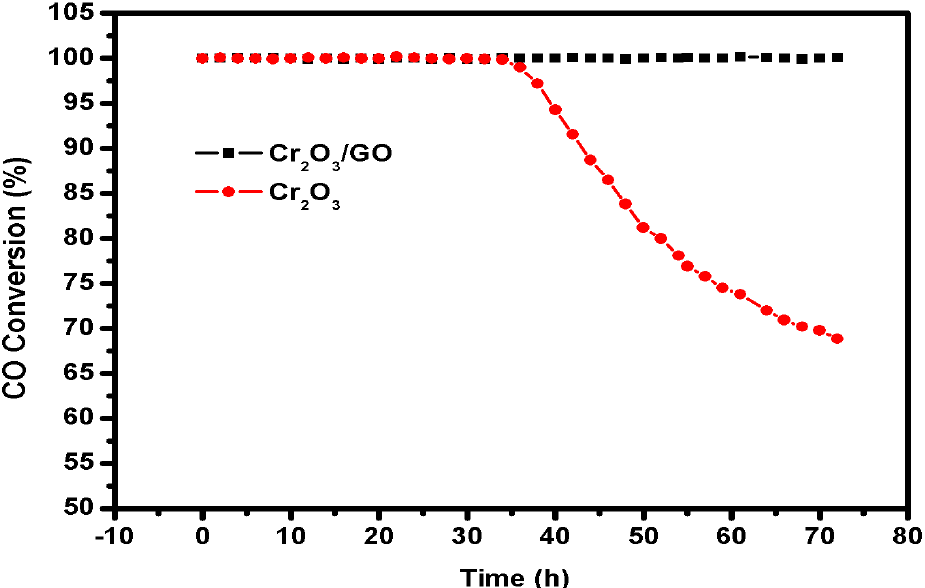
Figure 8. The stability test of the Cr 2 O 3 catalyst and the hybrid Cr 2 O 3 / GO for CO oxidation at the reaction temperature of 240 °C.